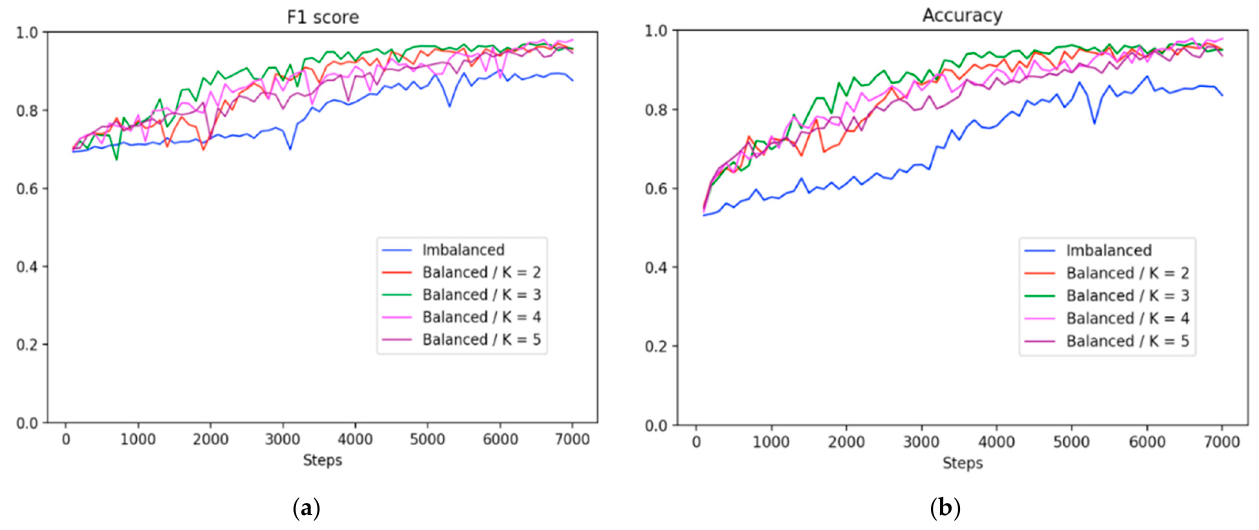
Figure 9. Comparison of the learning trajectories for various clusters. ( a ) F1 score and ( b ) accuracy.